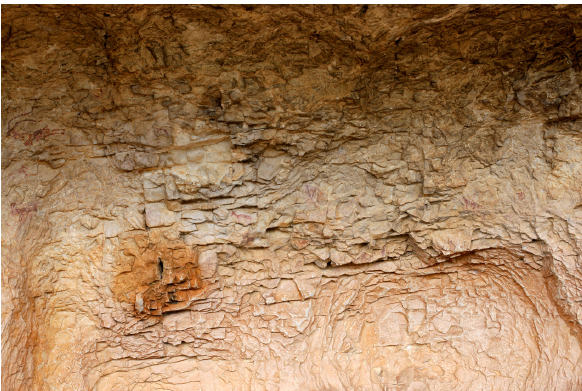
Figure 3. Example of high resolution image used to create high resolution point clouds of certain areas within Shelter